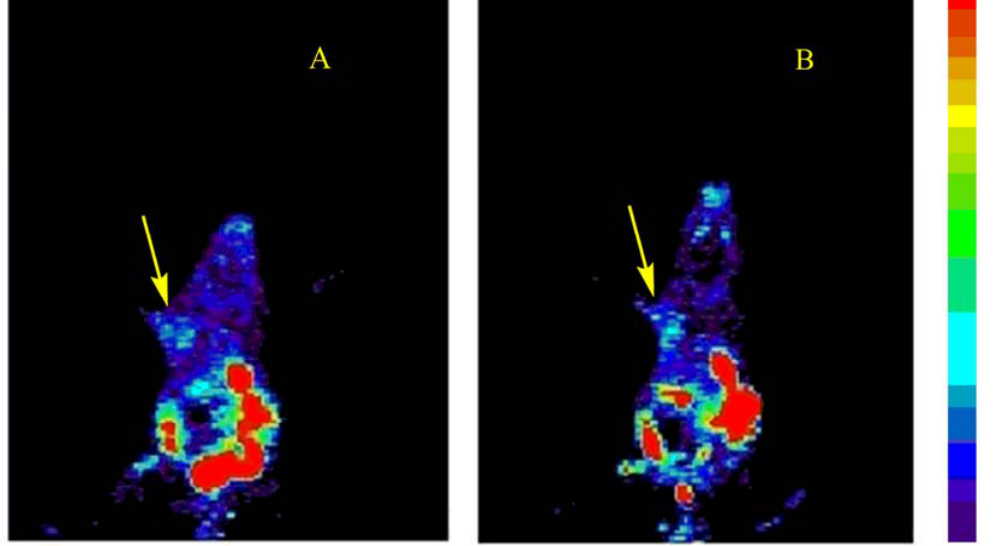
Figure 5. Coronal PET images of Kunmin mice with S180 tumor (arrow) in the left front flank at 30 min ( A ) and 60 min ( B ) post-injection of [ 18 F] 3